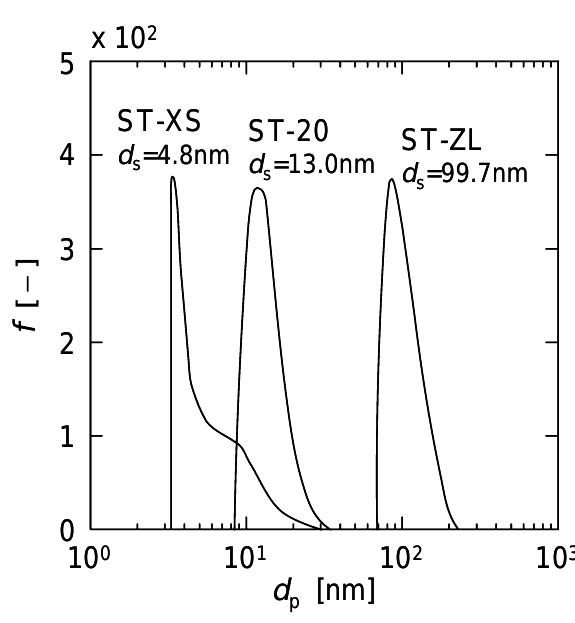
Figure 1. Size distributions of nanoparticles.